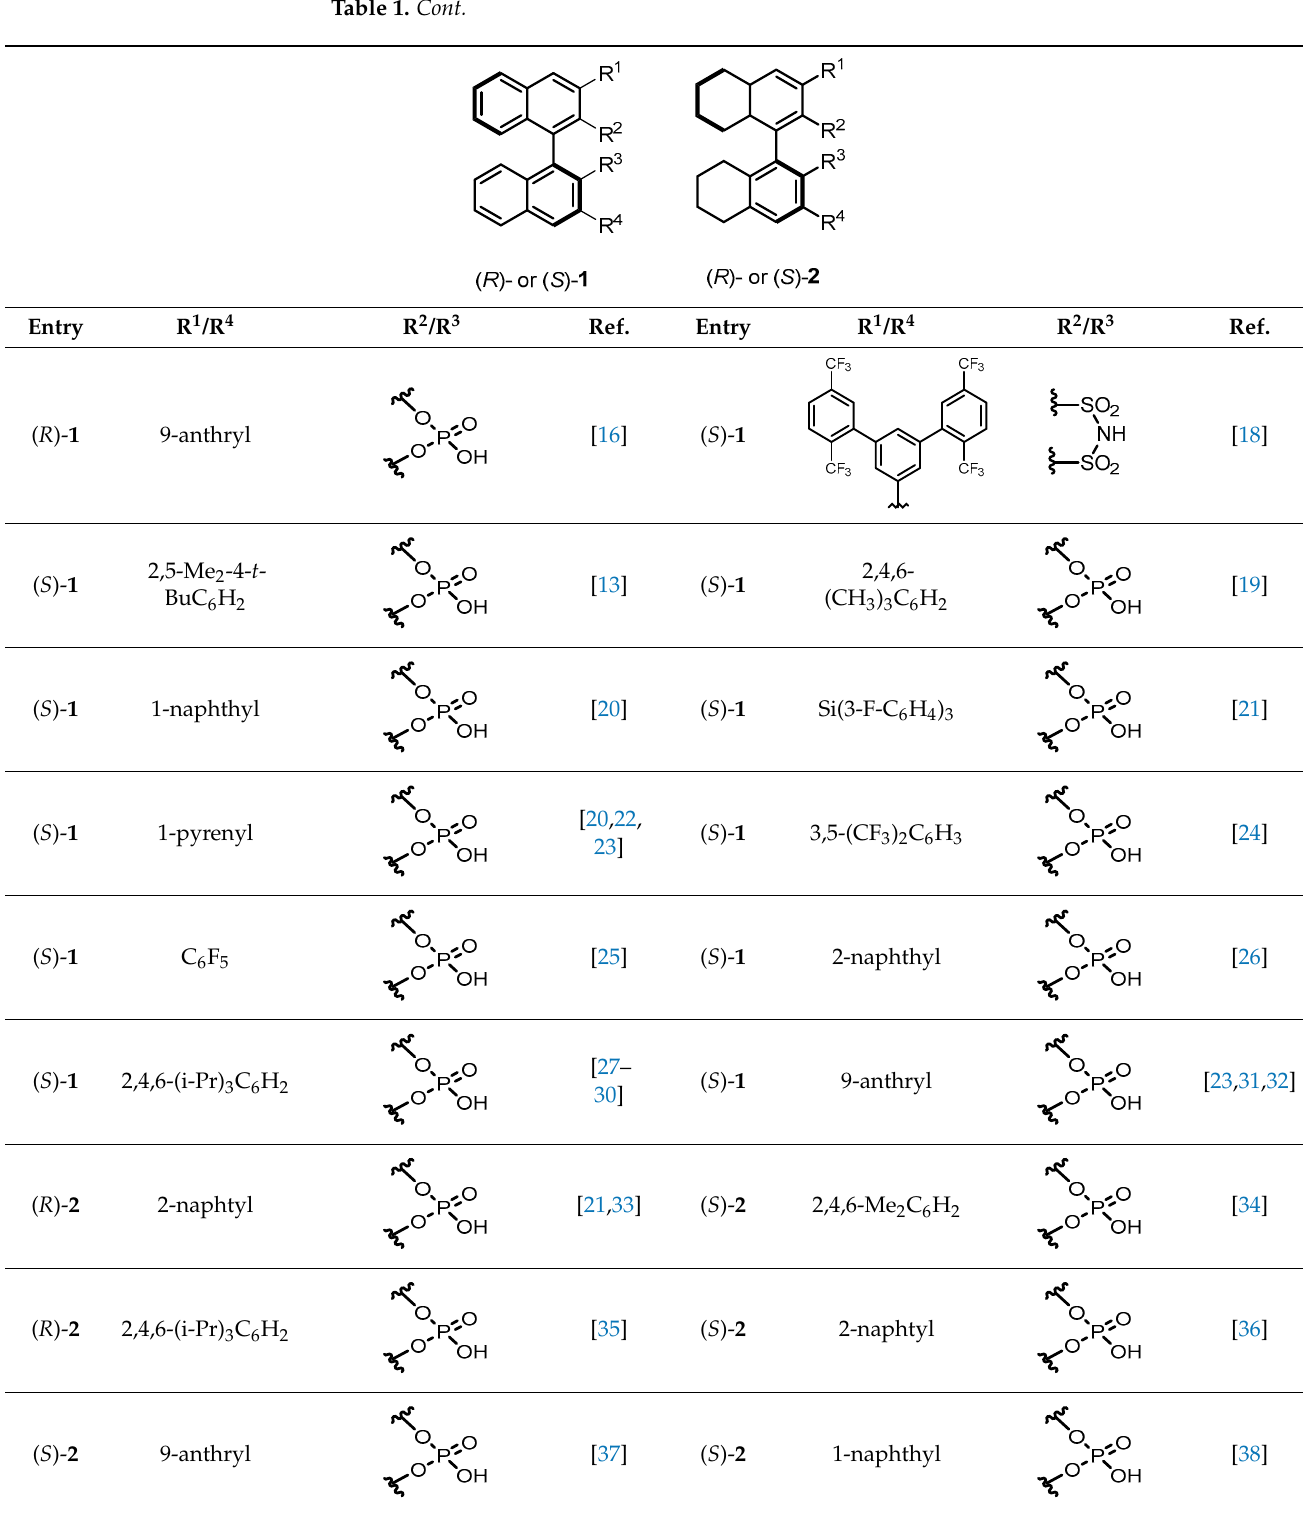
Figure 2. Examples of biologically active compounds with axial chirality.